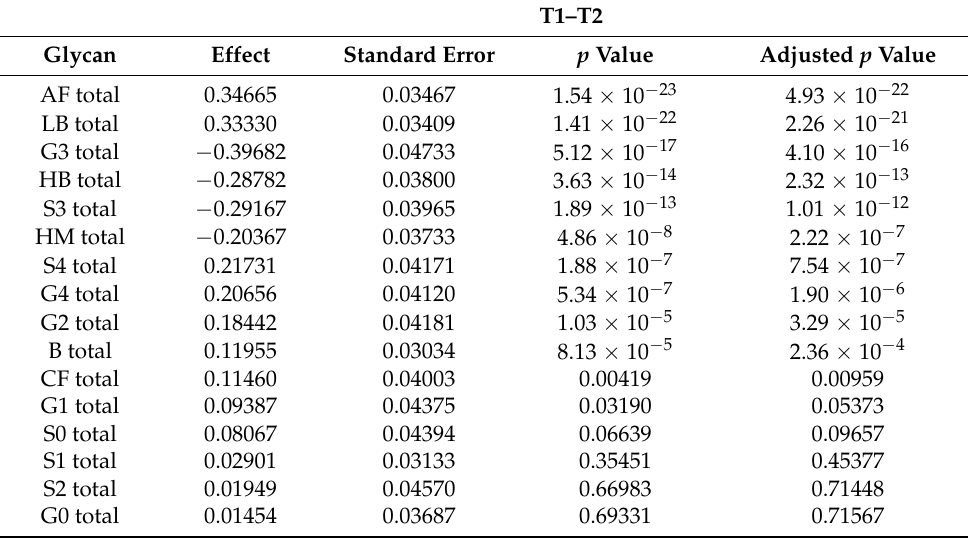
Table 1. Changes in plasma N-glycome composition in the first time period (T1–T2) after meta- analysis. Eleven out of sixteen derived glycan traits showed statistically significant changes in their levels after subjects spent 8 weeks on the low-calorie diet (adjusted p -value < 0.05). AF—total glycans with antennary fucose; LB—total low branching glycans; HB—total high branching glycans; S0—total neutral glycans; S1—total monosialylated glycans; S2—total disialylated glycans; S3—total trisialylated glycans; S4—total tetrasialylated glycans; G0—total agalactosylated glycans; G1—total monogalactosylated glycans; G2—total digalactosylated glycans; G3—total trigalactosylated glycans; G4—total tetragalactosylated glycans; HM—total high-mannose glycans; B—total glycans with bisecting GlcNAc; CF—total glycans with core